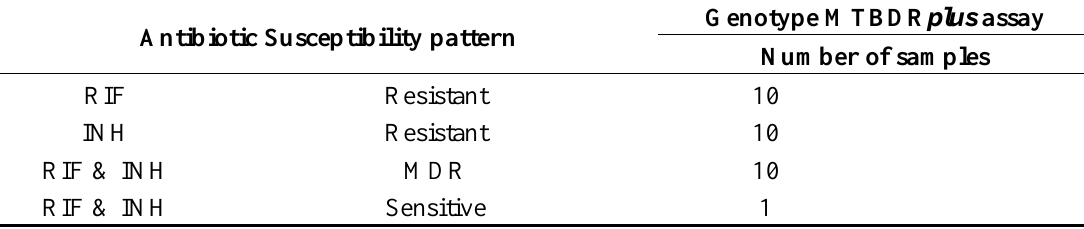
Table 2. Drug susceptibility pattern of the